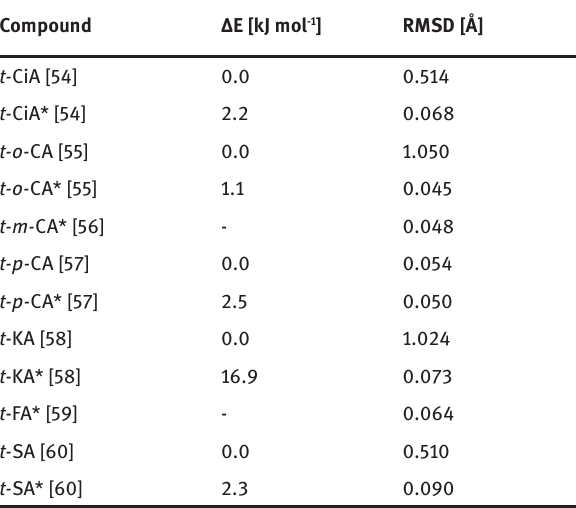
*Rotamers which geometries correspond to the available crystal structures. The values of ΔE [kJ mol -1 ] represent the energy difference between the most stable calculated rotamers (0.0 kJ mol -1 ) and rotamers marked with *.